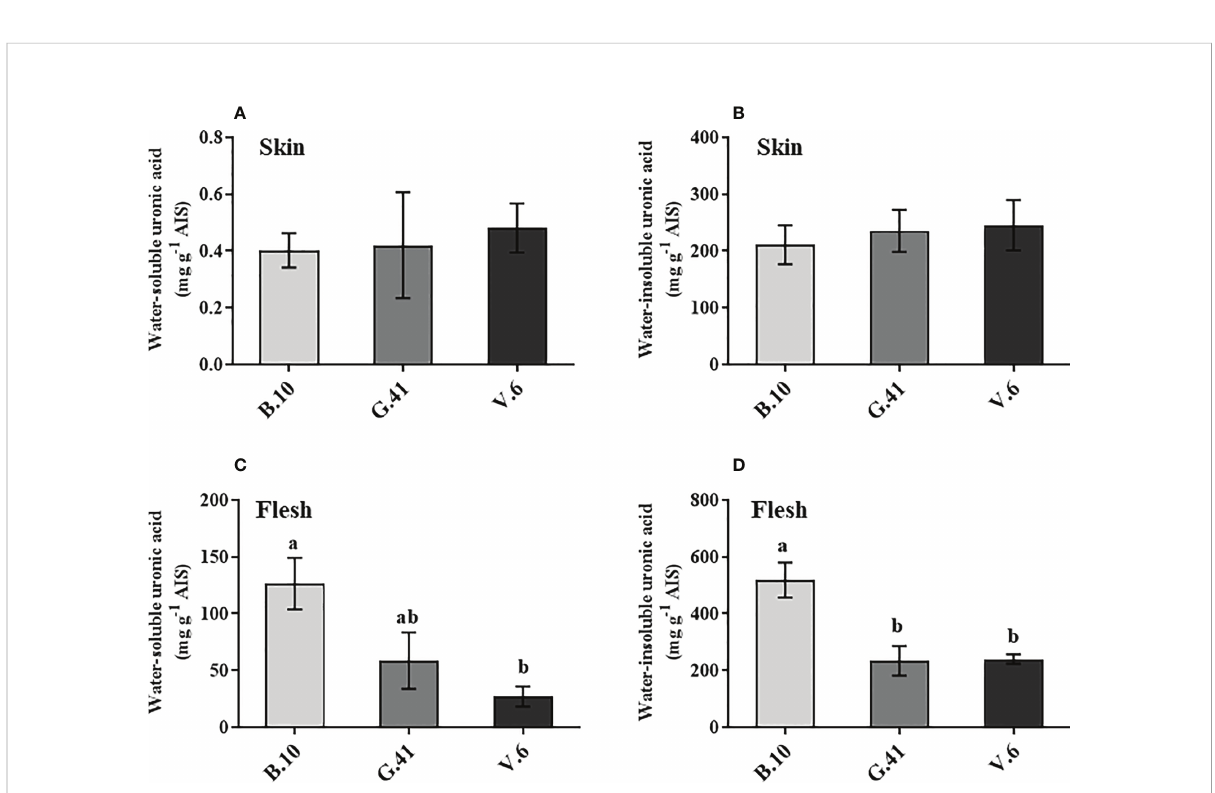
FIGURE 4 The uronic acid content in skin and fl esh tissue of ‘ Honeycrisp ’ apples from different rootstocks. (A, B) Water-soluble and water-insoluble uronic acid in skin tissue, (C, D) Water-soluble and water-insoluble uronic acid in fl esh tissues of ‘ Honeycrisp ’ apples from B.10, G.41 and V.6 after two months of cold storage. Means not sharing any letter are signi fi cantly different at P < 0.05, according to Tukey ’ s HSD test. AIS: Alcohol insoluble cell wall substance.